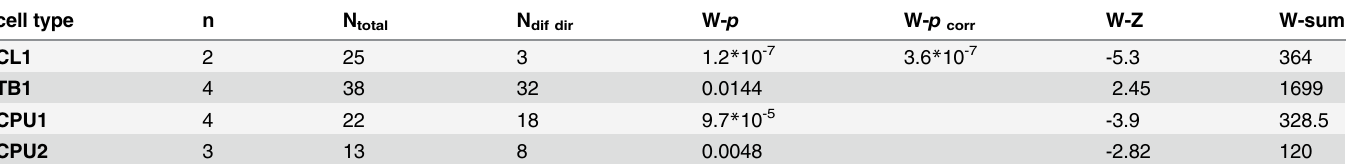
Table 1. Statistics of data distributions shown in Fig 4A.